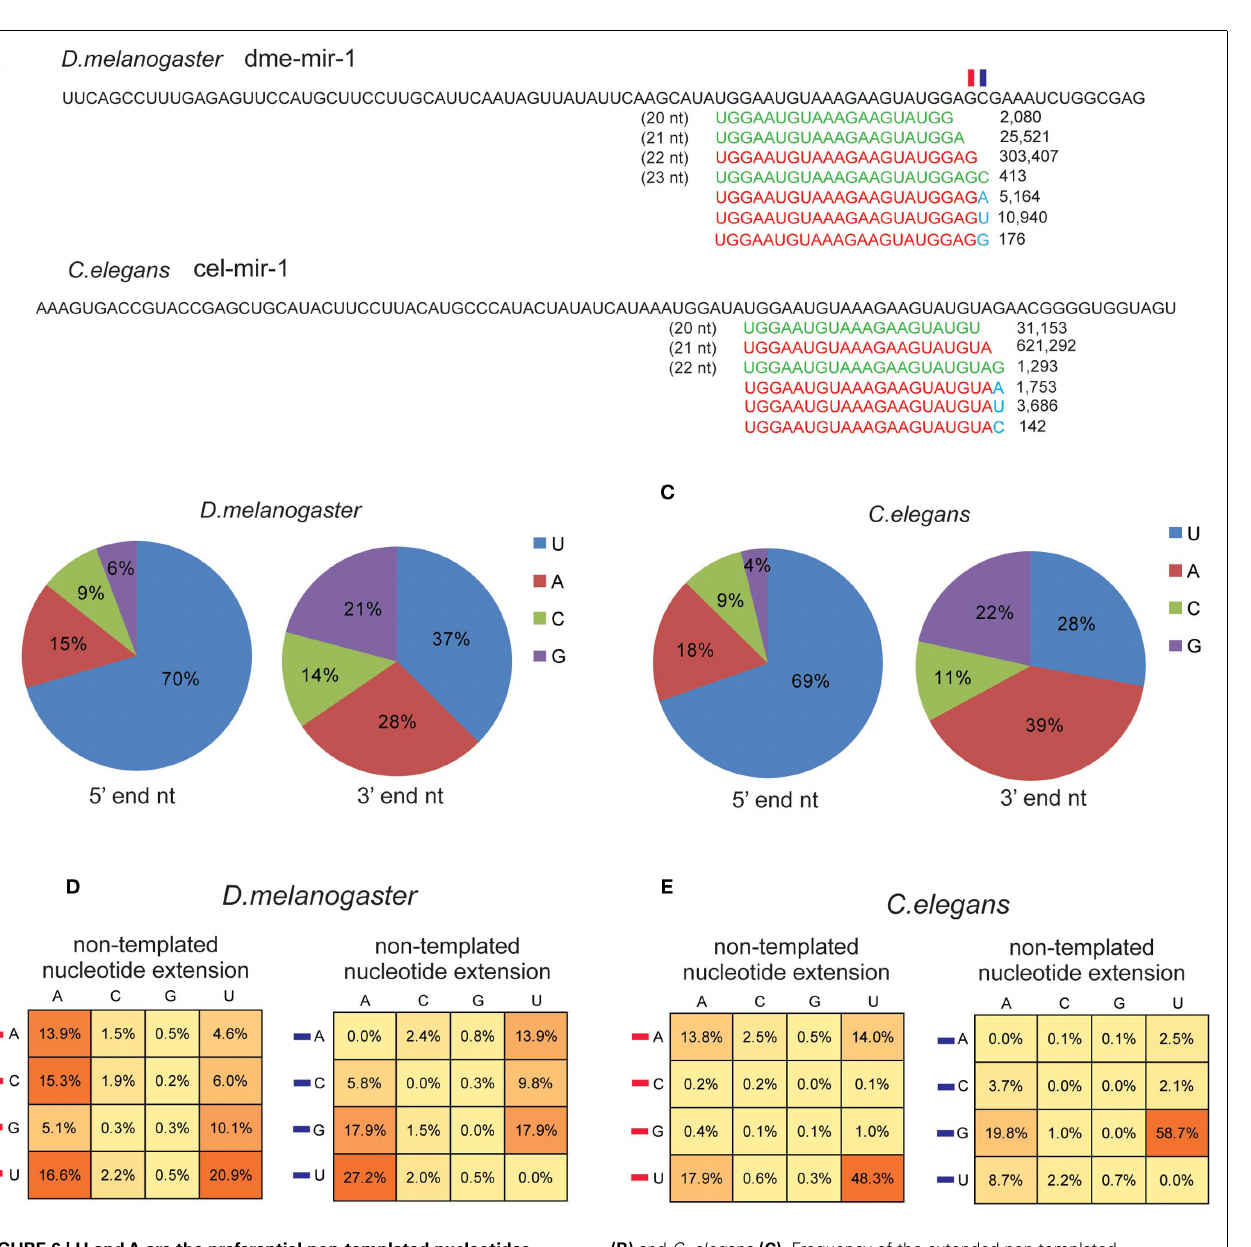
(B) and C. elegans (C) . Frequency of the extended non-templated nucleotide based on the type of the last nucleotide (denoted by a red rectangle in miR-1 example) and the following nucleotide (denoted by a blue rectangle in miR-1 example) in D. melanogaster (D) and in C. elegans (E)